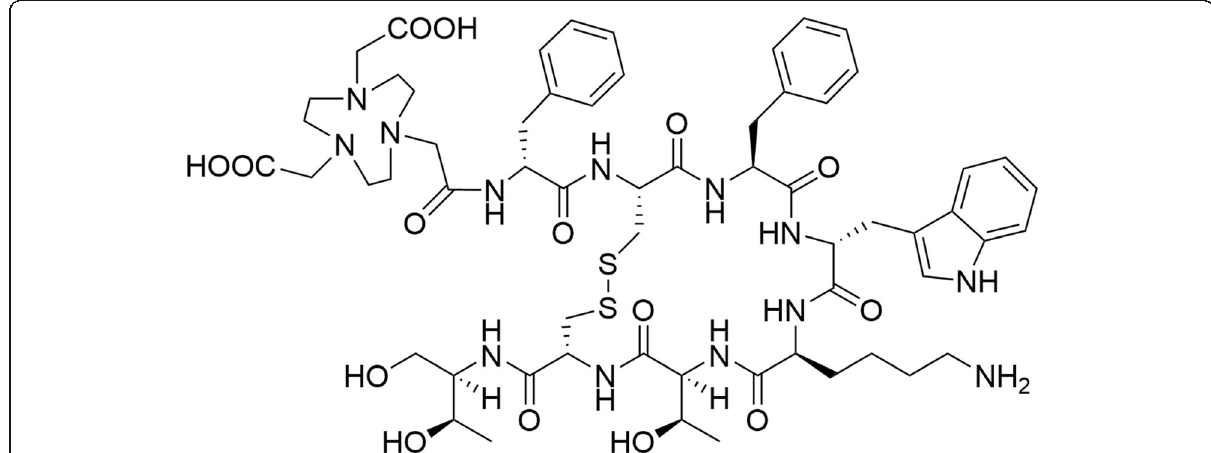
Fig. 1 The chemical structure of